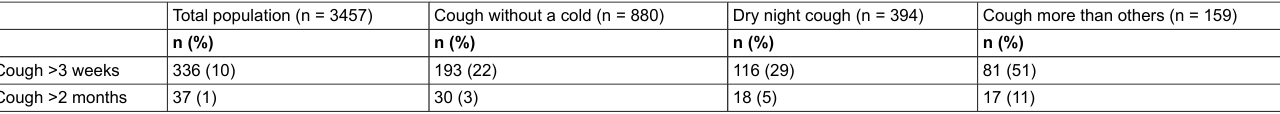
Table S2: Comparison of cough duration among children with parent-reported cough apart from colds, dry night cough and cough more than others in the LuftiBus in the School study. Total population (n = 3457)